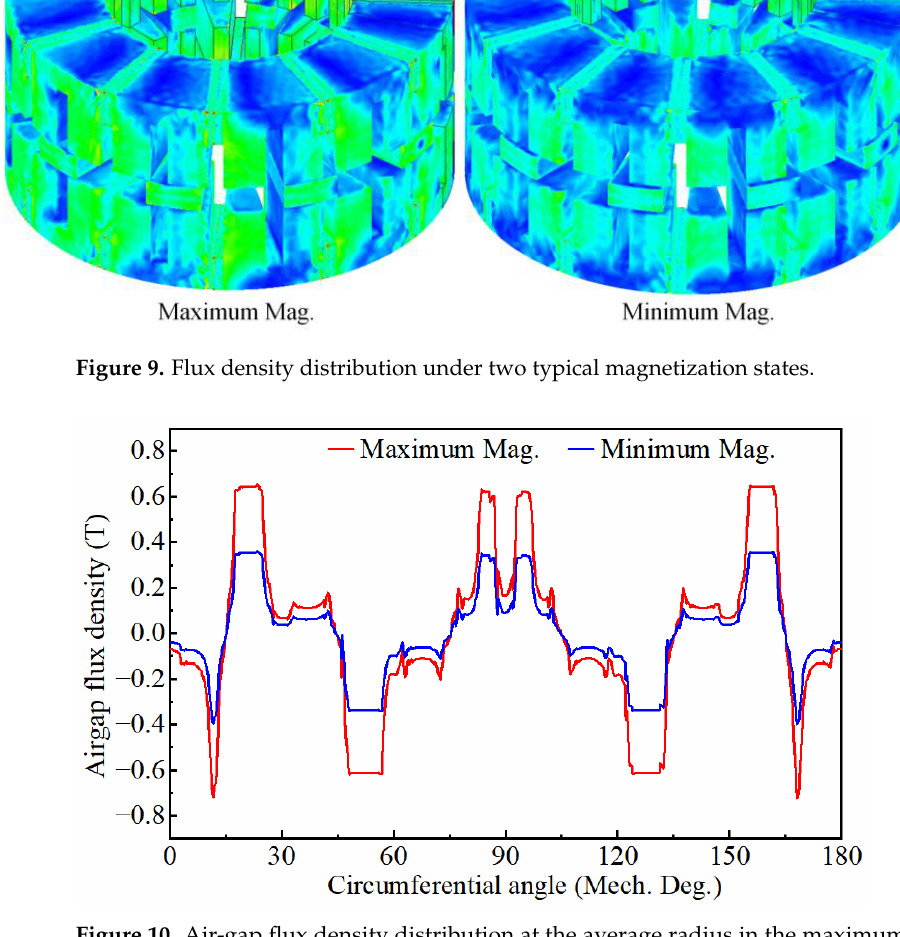
Figure 10. Air-gap flux density distribution at the average radius in the maximum and minimum magnetization states.